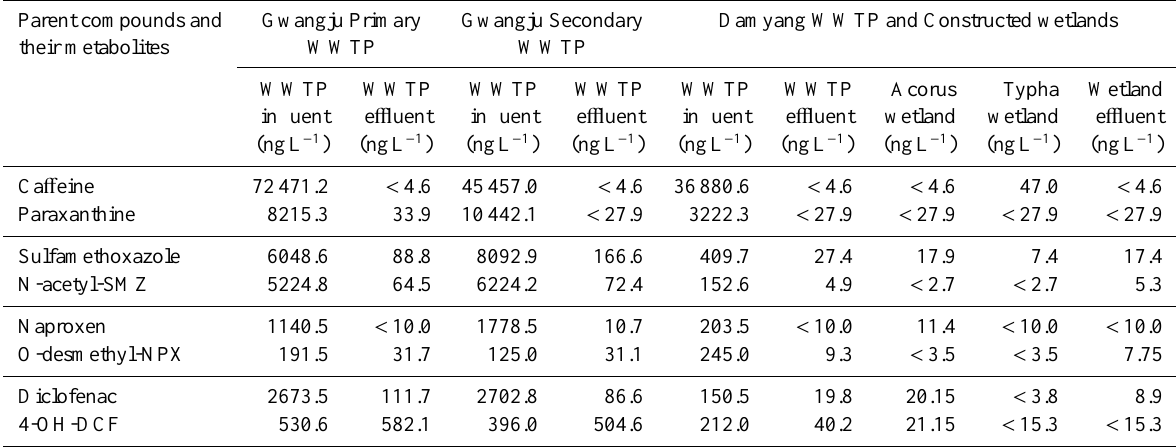
Table 4. Concentrations of parent pharmaceuticals and their metabolites in WWTPs and wetlands. Parent compounds